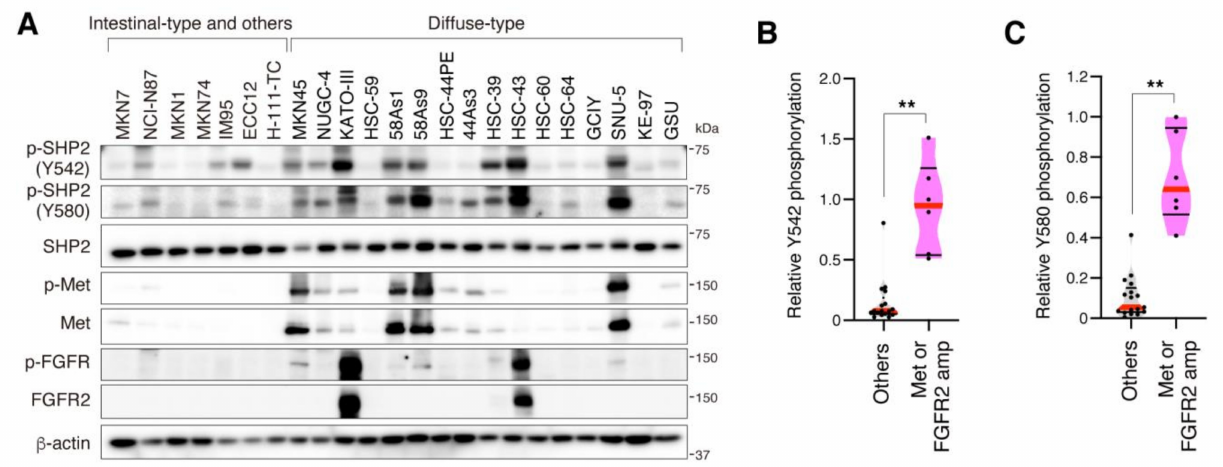
Figure 1. Tyrosine phosphorylation of SHP2 in gastric carcinoma cell lines. ( A ) Human gastric carcinoma cell lines were subjected to immunoblotting with indicated antibodies. ( B , C ) Violin plots show relative phosphorylation levels of SHP2 Y542 ( B ) and Y580 ( C ) that were calculated from the immunoblot data and compared between cell lines with or without Met or FGFR2 gene amplification. Red lines denote medians and black lines denote quartiles ( n = 17 for others and 6 for Met or FGFR2 gene amplification). **, p <